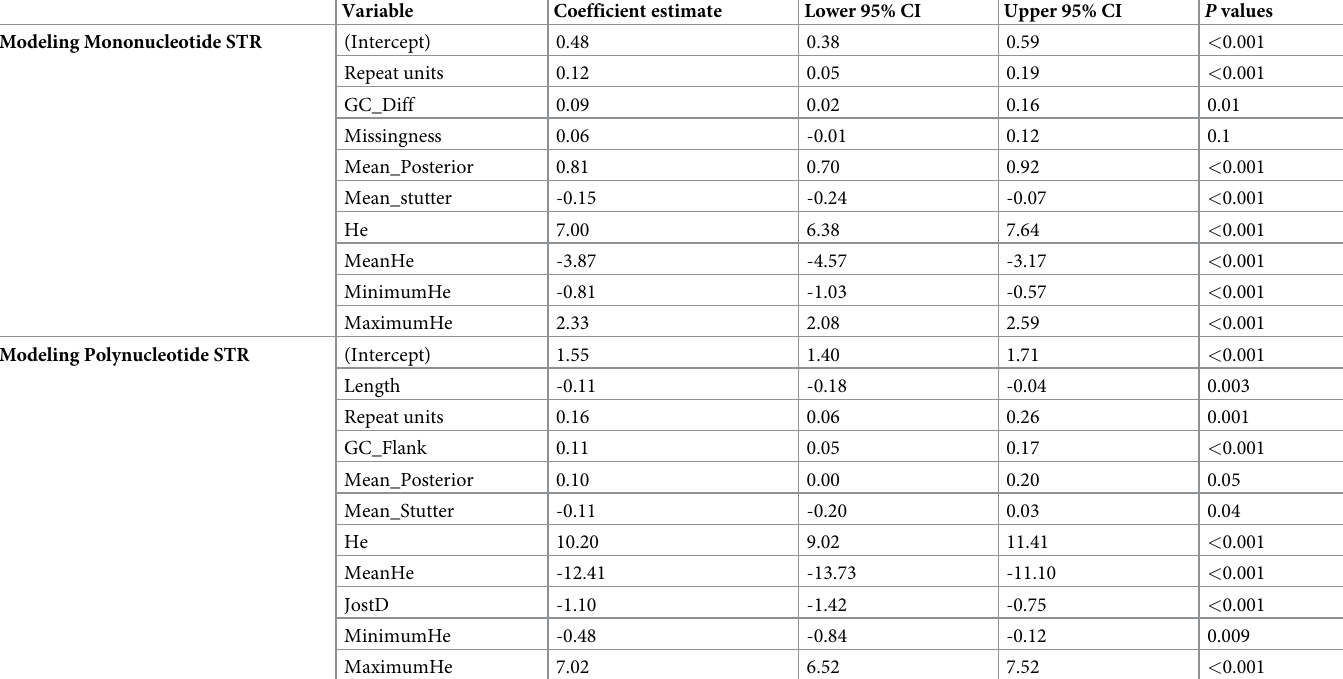
Table 1. Multivariable logistic regression model’s estimated coefficients and respective 95% confidence intervals.